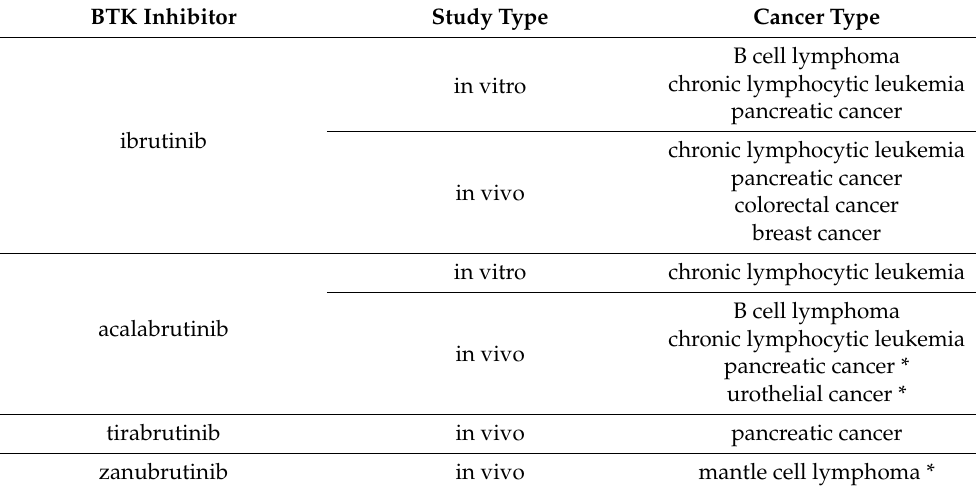
Table 1. Summary of BTK inhibitors that have been evaluated in cancer